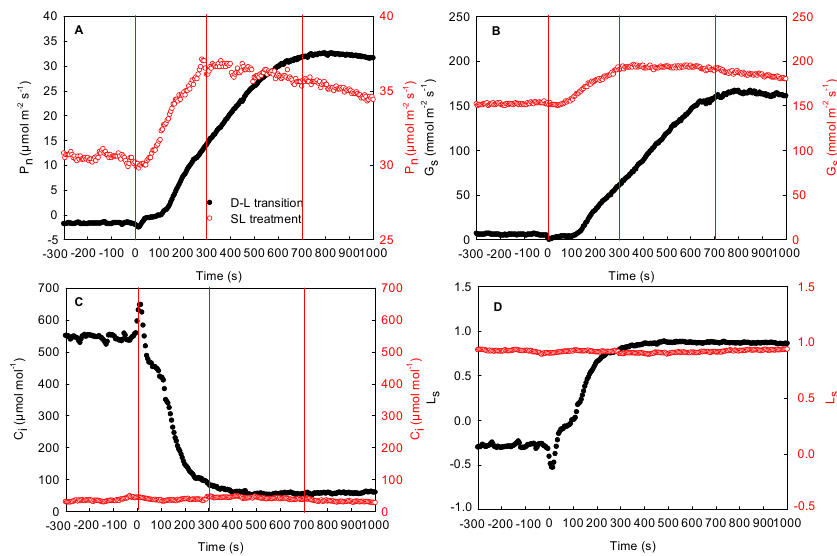
Figure 7. Effect of local illumination on the photosynthetic rate of the adjacent region in the same maize leaves. ( A ) photosynthetic induction under the dark–light transition in the local regions or photosynthetic rate under steady light intensity in the adjacent region; ( B ) stomatal conductance under the dark–light transition in the local regions or under steady light intensity in the adjacent region; ( C ) intercellular CO 2 concentration under the dark–light transition in the local regions or region under steady light intensity in the adjacent; ( D ) stomatal limitation under the dark–light transition in the local regions or under steady light intensity in the adjacent region. C i , intercellular CO 2 concentration; D–L transition, dark–light transition; G s , stomatal conductance; L s , stomatal limitation; P n , photosynthetic rate; SL treatment, steady light treatment.